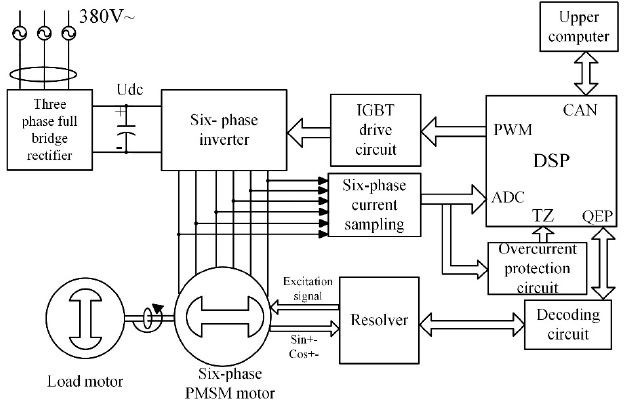
Figure 22. Overall block diagram of the six-phase PMSM control system.